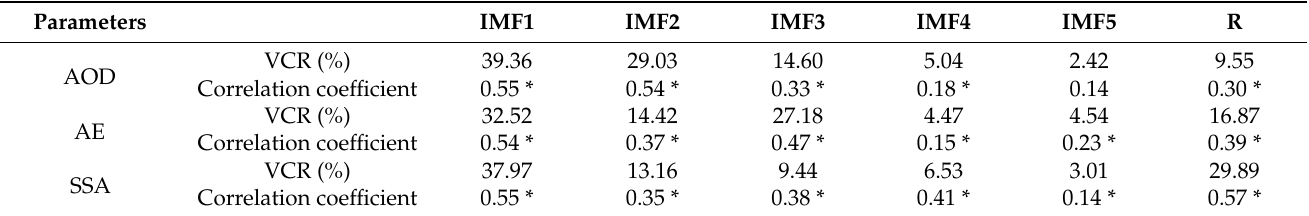
Table 2. Variance contribution rate (VCR) and correlation coefficient of the decomposed results.